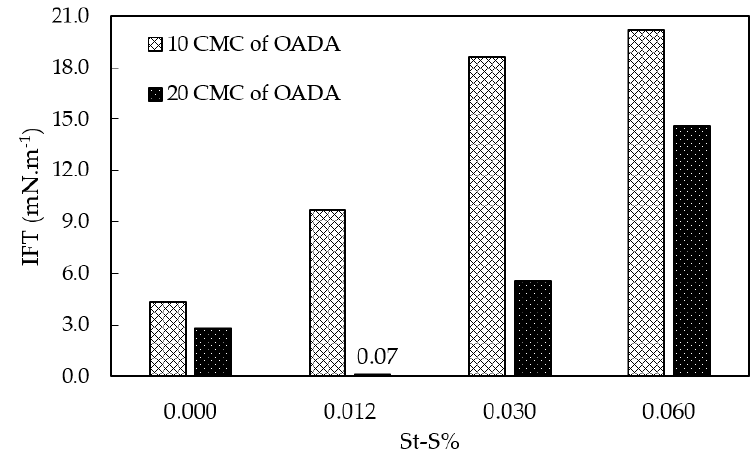
Figure 10. Influence of St-S content on the interfacial tension between 0.1 ( m / v ) % SPSNP suspensions in deionized water and mineral oil.